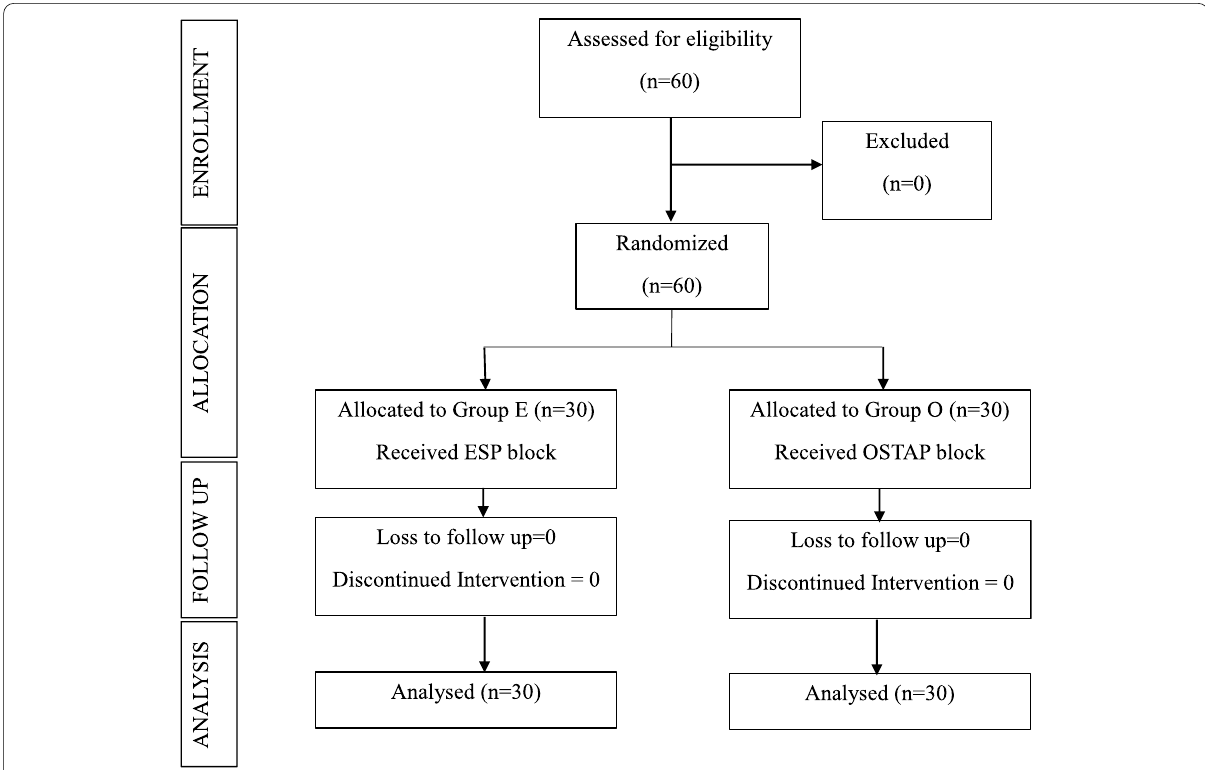
Fig. 1 CONSORT flow diagram of the study